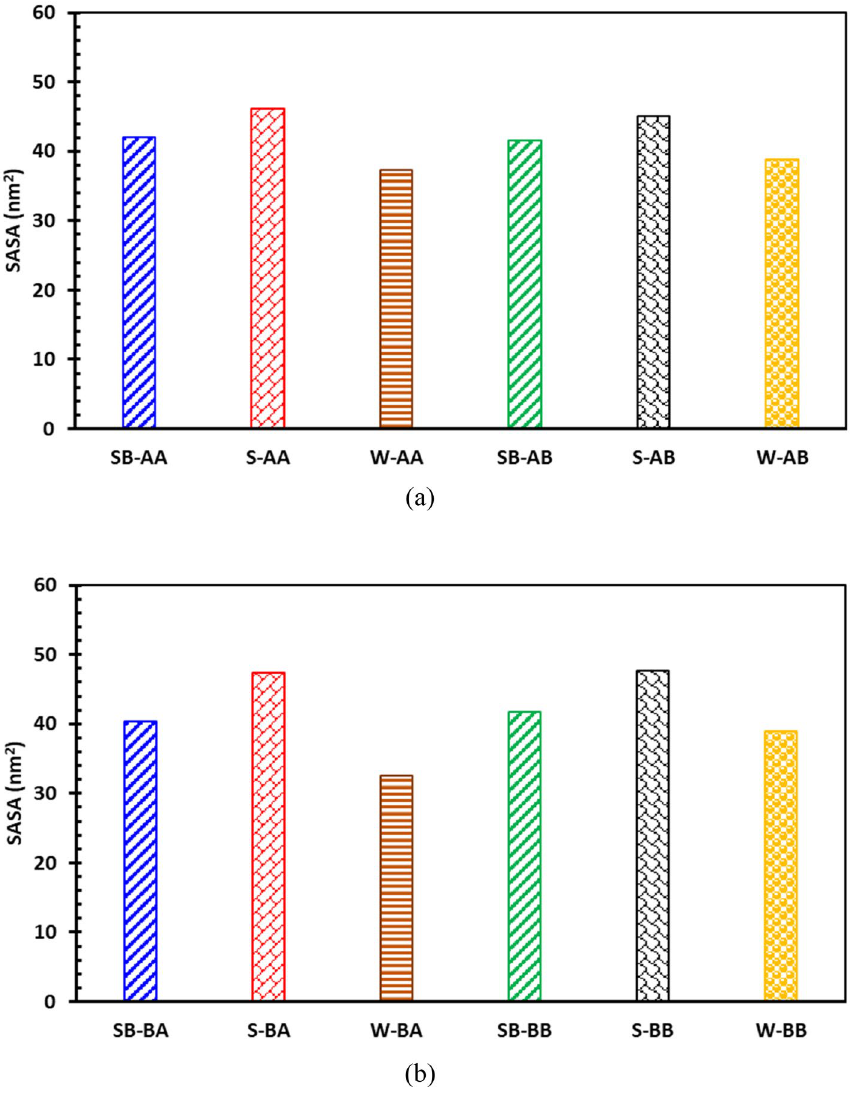
Figure 18. Comparison between SASAs of different systems containing ( a ) C 40 H 30 O 2 and ( b ) C 44 H 40 N 2